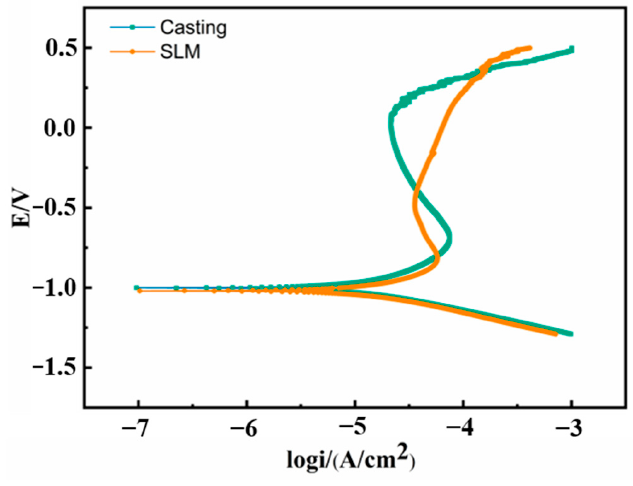
Figure 10. Polarization curves of as-cast and SLM samples. Table 2. Polarization test results for casting and SLM samples.